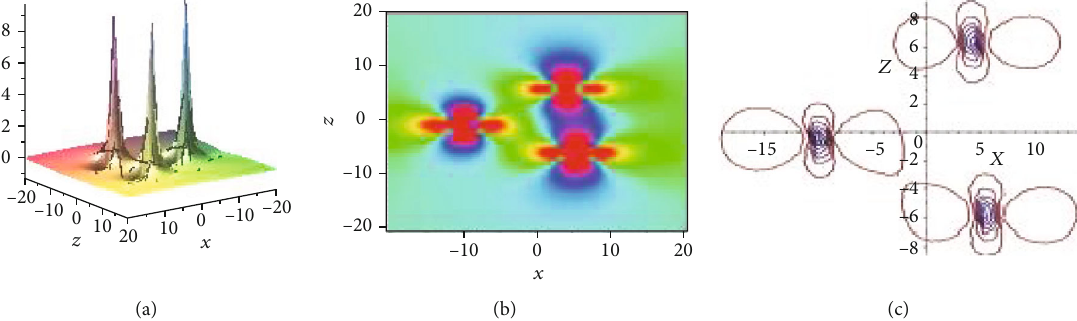
Figure 1: The 1-lump solution u of Equation (1) with the parameter selections m = − 2, n = 2, c = 1, u the wave u ð X , Z Þ , (b) overhead view of the wave u ð X , Z Þ , and (c) the corresponding contour plot u ð X , Z Þ .